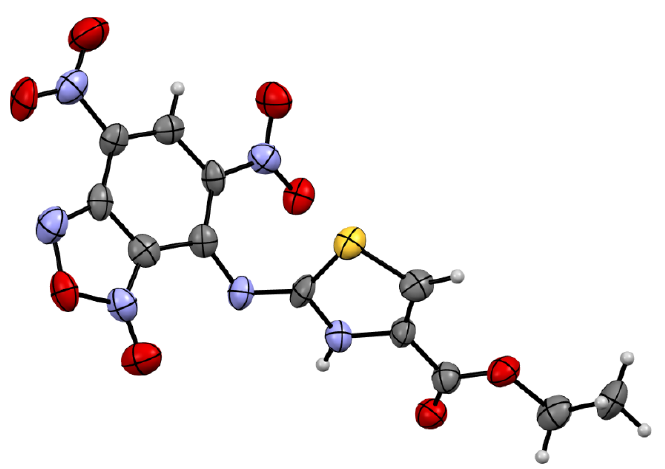
Figure 4. Molecular structure of Compound 3c . Yellow—sulfur, red—oxygen, blue—nitrogen, and grey—carbon.